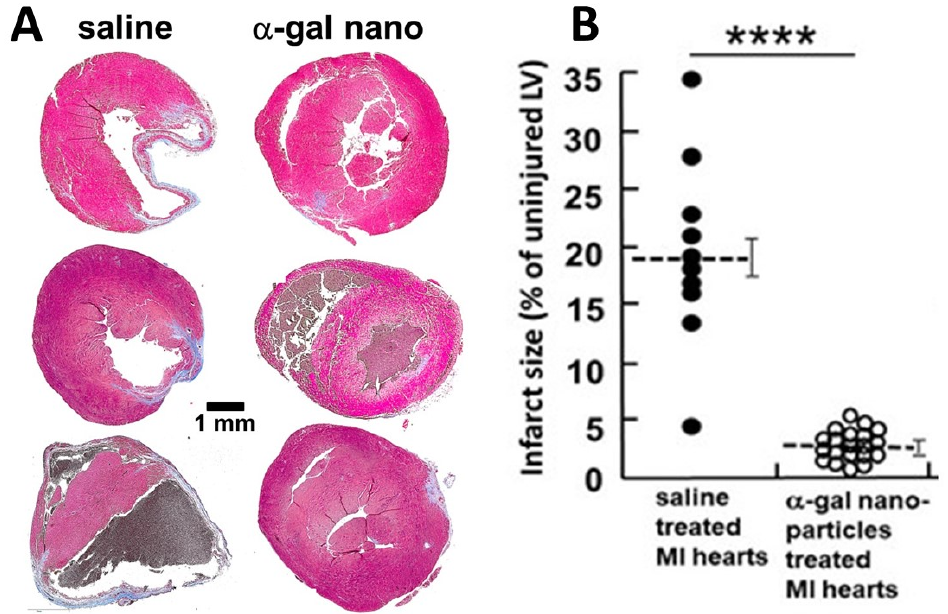
Figure 9. GT-KO mouse hearts undergoing MI by occlusion/reperfusion, treated post-MI with two intramyocardial injections of 10 μ l saline or α -gal nanoparticles (10 mg/mL) and inspected 28 days post treatment. ( A ) The hearts were sectioned and stained with Masson trichrome for identification of scar tissue. Representative saline treated hearts displayed scar formation and thinning of the ventricular wall whereas α -gal nanoparticles treated hearts displayed near complete regeneration of the ventricular wall. ( B ) Planimetry studies of fibrosis and scar formation in hearts from 10 saline treated and 20 α -gal nanoparticles treated hearts. Mean ± S.E., **** p < 0.0001. Adapted from ref. [19].